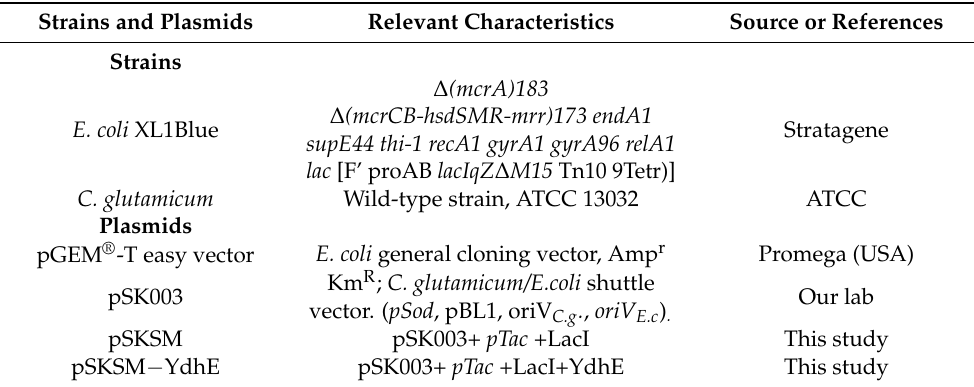
Table 1. Bacterial strains and plasmids used in this